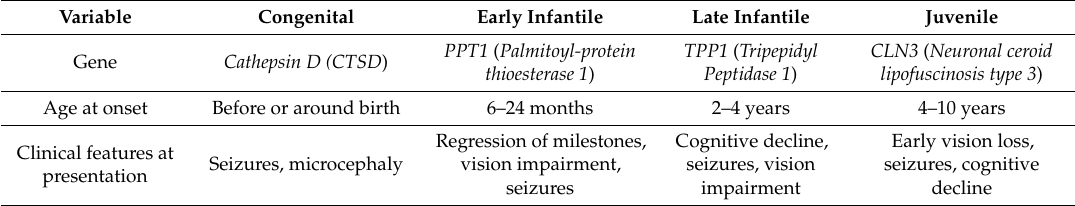
Table 3. Clinical features of neuronal ceroid